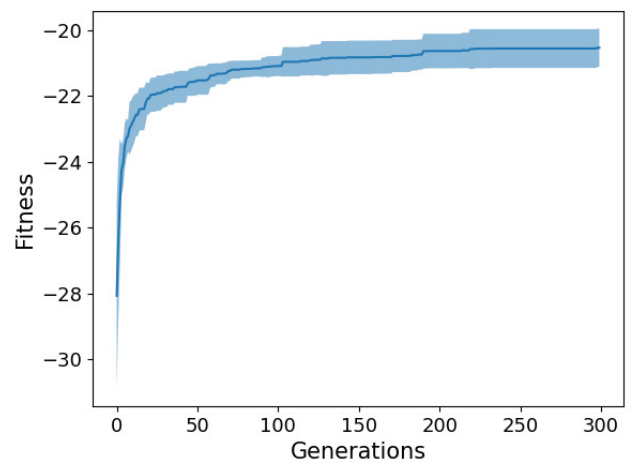
Figure 4. Fitness across generations (mean ± std. dev. across 10 independent runs) for SNPS (4) on N-CMAPSS (DS02).